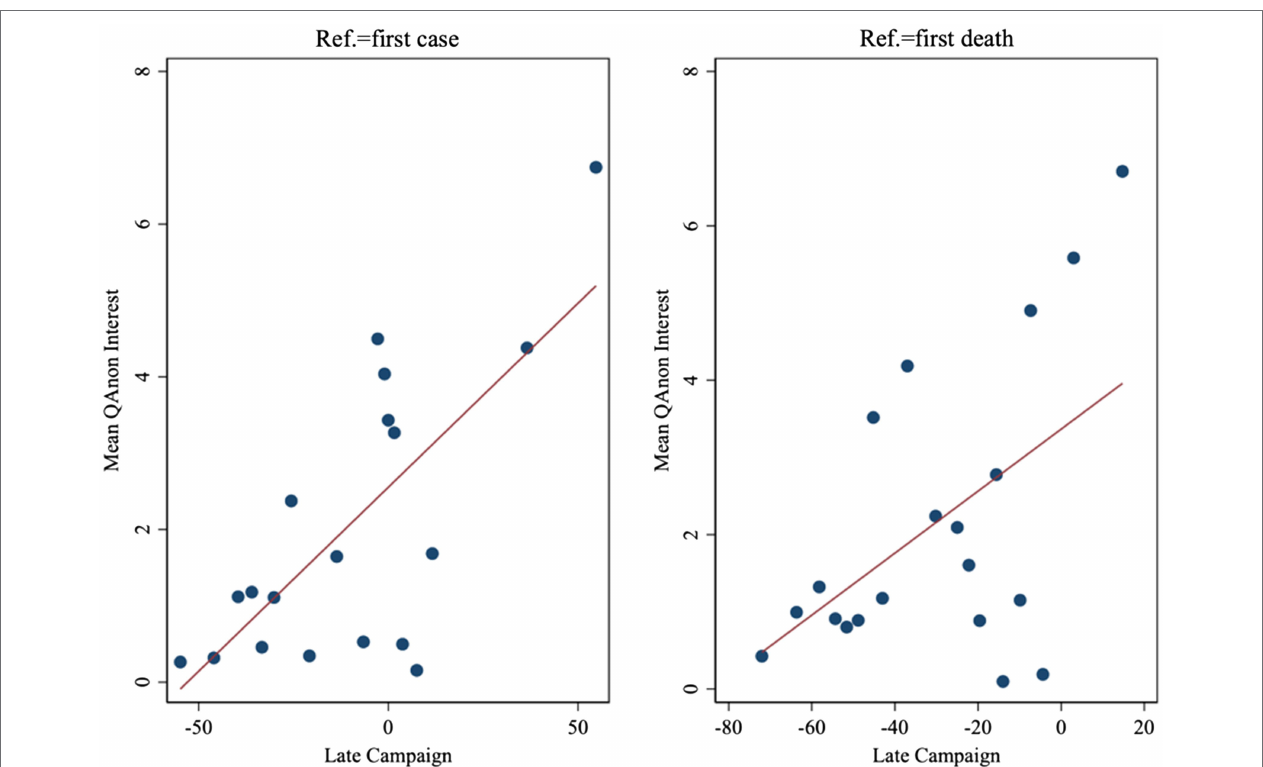
FIGURE 1 | Binned scatterplot of interest in QAnon and Late Campaign .